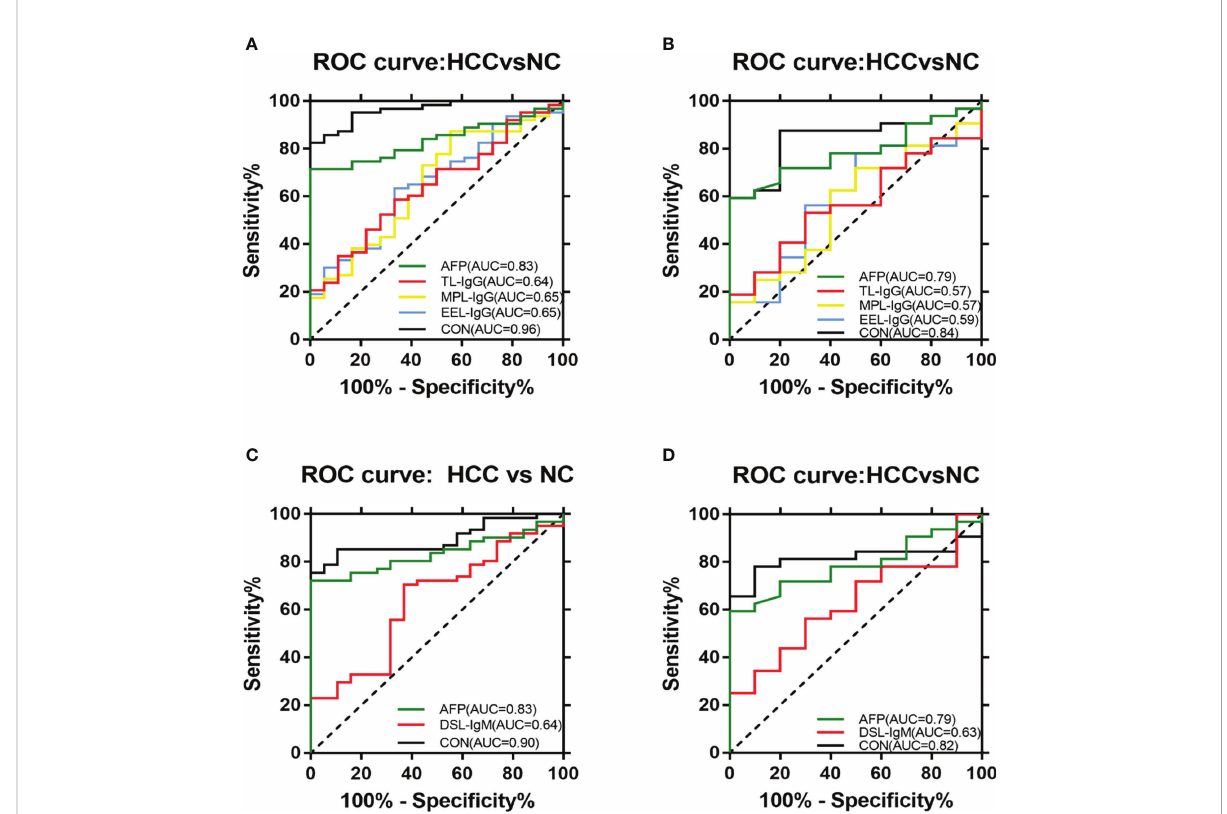
FIGURE 5 ROC analyses of the diagnostic value for HCC. (A) ROC analyses based on the IgG training group. (B) ROC analyses based on the IgG validation group. (C) ROC analyses based on the IgM training group. (D) ROC analyses based on the IgM validation